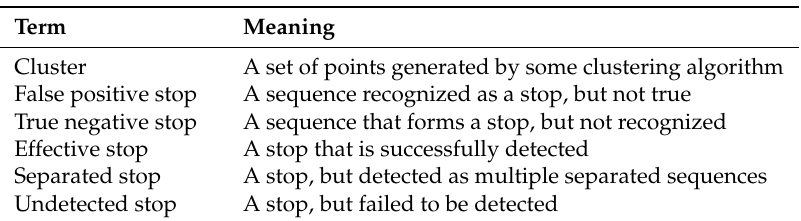
Table 1. Meanings of stop-related